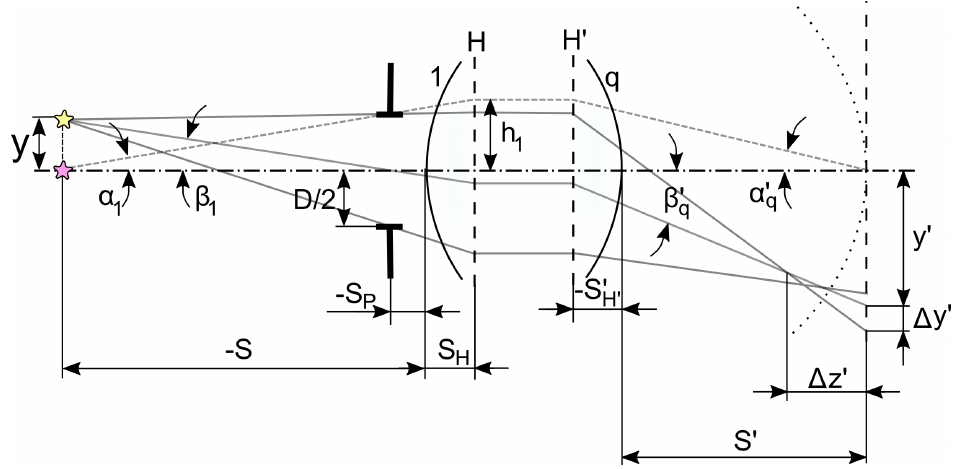
Figure 1. General raytracing scheme used to derive the field